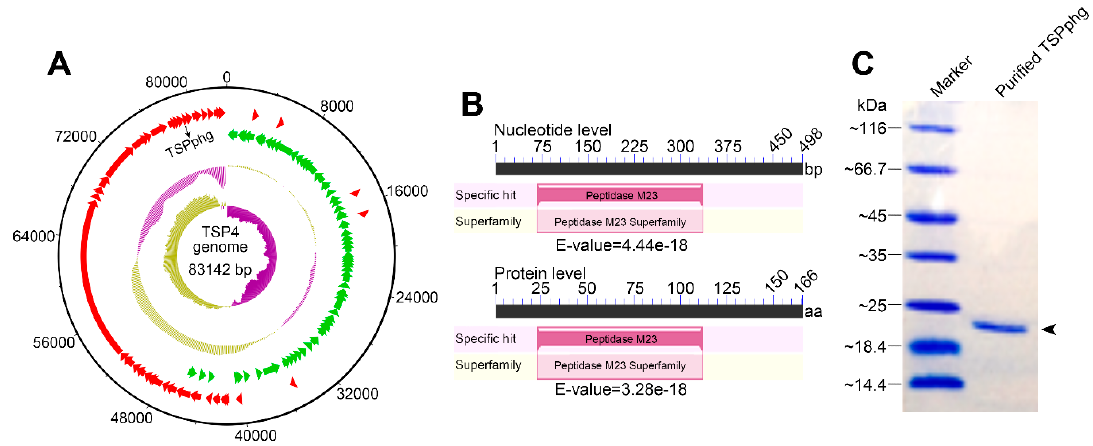
Figure 1. Identification of TSPphg by sequencing the complete genome sequence of Thermus phage TSP4. ( A ) Genome map of TSP4, from inside to outside: circle 1 displays the GC skew ((G − C)/(G+C)); circle 2 shows the GC percentage plot; circles 3 and 4 denote the ORFs on the minus (‘-’) strand (green) and plus (‘+’) strand (red), respectively; circle 5 demonstrates the numbered scale with an interval of 4 kb. ( B ) The conserved domain analysis of TSPphg at both nucleotide and protein levels. ( C ) SDS-PAGE analysis of the purified TSPphg in this study. The black arrowhead denotes the band of recombinant TSPphg lysin.